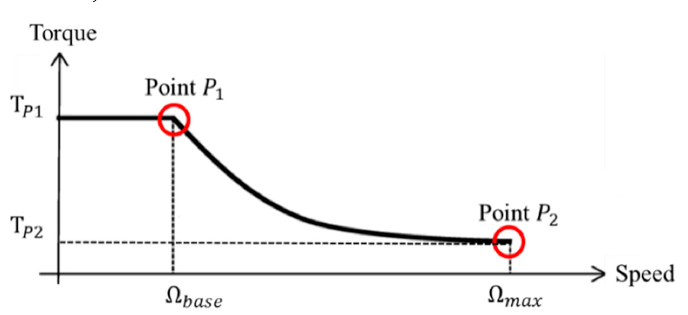
Figure 6. Operating points used for optimization.